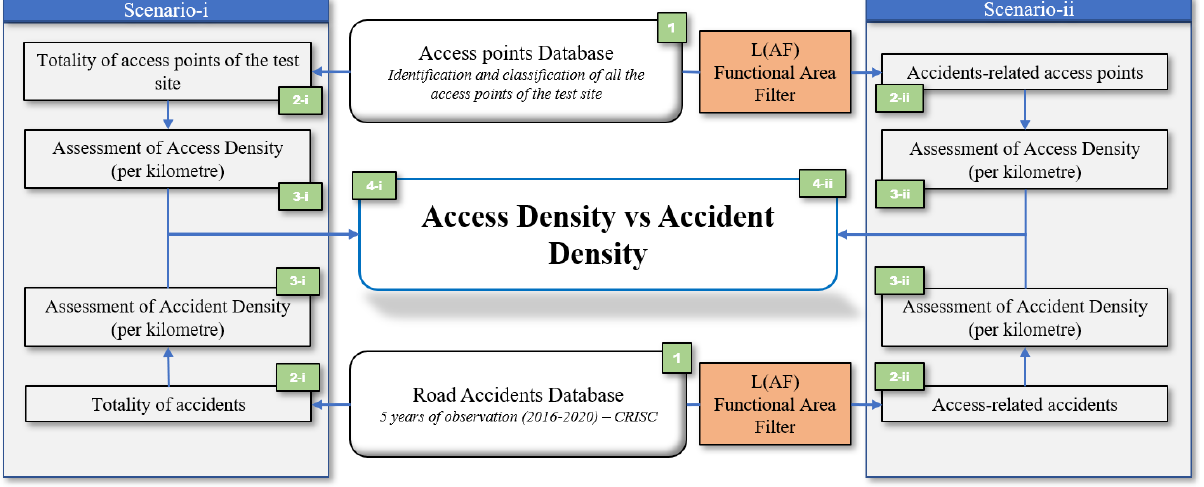
Figure 5. The framework of analysis levels: access points database and road accidents database are the input information ( 1 ) for both scenarios “i” and “ii”; data is selected from these databases ( 2 ) for the assessment of the variables Access Density or Accident Density ( 3 ); the Functional Area Filter impacts this activity for Scenario-ii. The last level of the approach is the analysis of the relationship between Access Density and Accident Density ( 4 ).